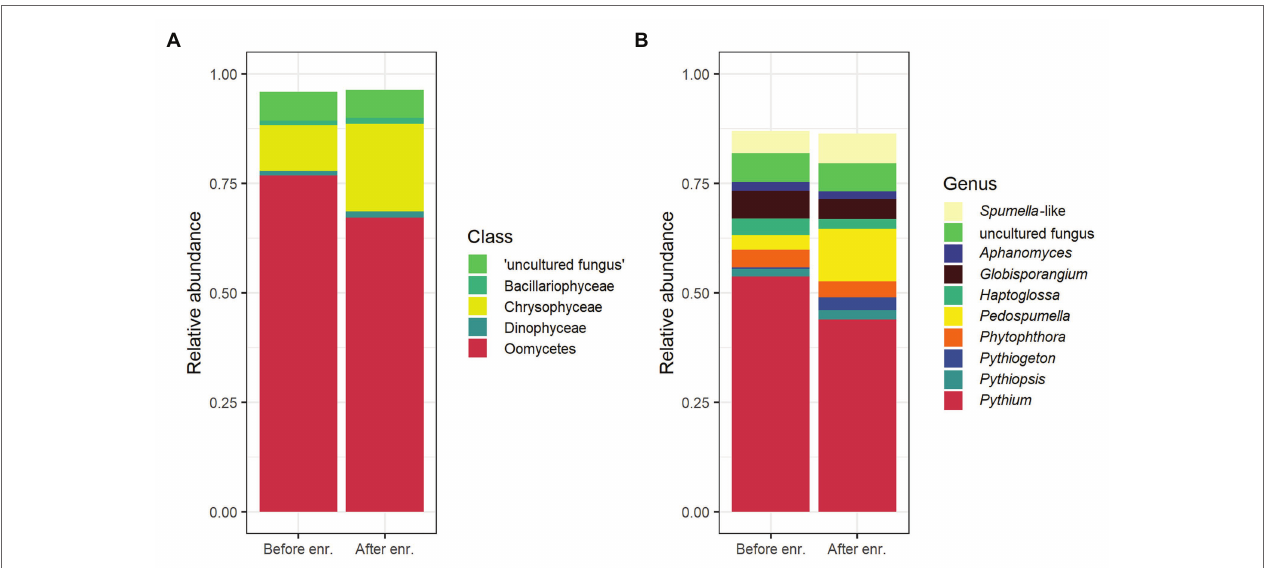
FIGURE 1 | Overview of the most abundant organisms in rhizospheric soil samples detected by oomycete internal transcribed spacer (ITS) metabarcoding, means of all samples. Relative abundance of amplicon sequence variants (ASVs) belonging to the five most abundant taxonomic classes (A) and the 10 most abundant genera (B) before (“Before enr.”) and after enrichment (“After enr.”). In (B) , Globisporangium , Pythium , and Phytophthora are highlighted in bordeaux, red, and orange, respectively, while Aphanomyces and Phytiogeton are colored in shades of purple/dark blue. Supplementary Figure S3 shows a per-sample overview for the top five classes and top 10